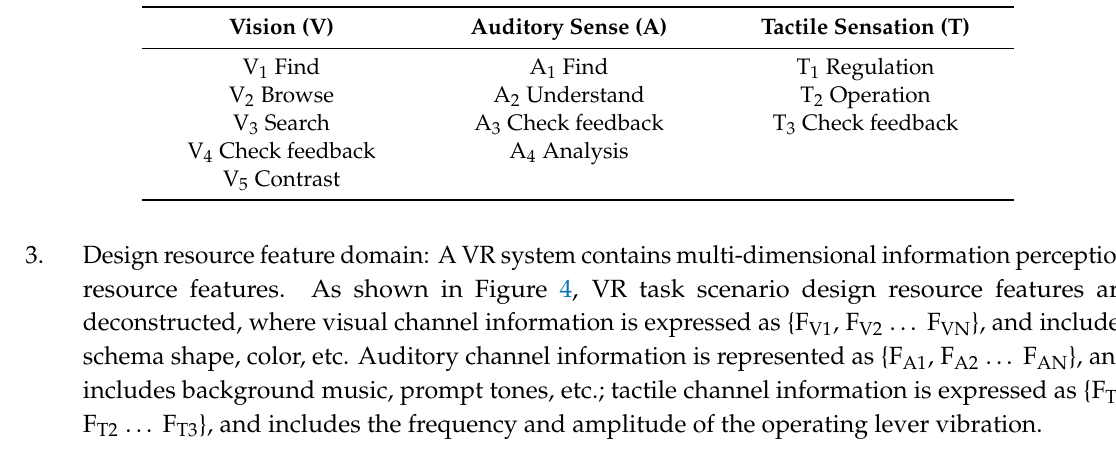
Table 1. Elements of user behavior feedback in cognitive